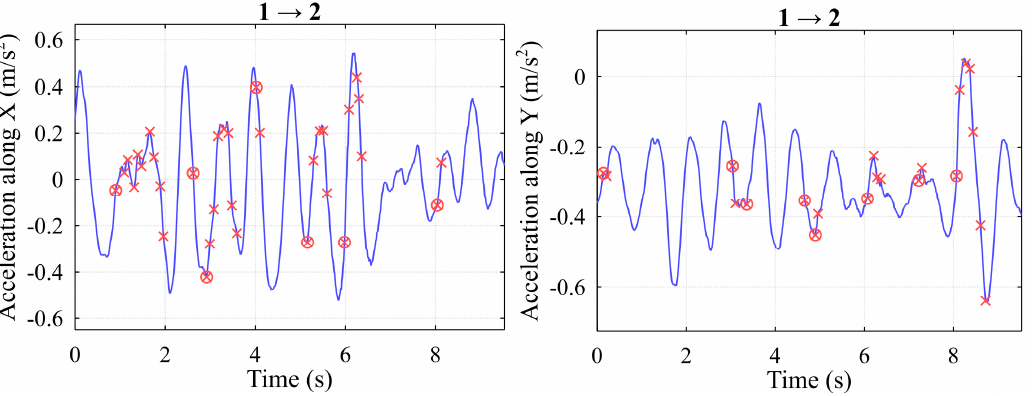
Figure 15. Use case No. 1 with the decreased threshold (detected impacts: ( left ) 7; ( right ) 8). A 10% decrease resulted in three additional detections along the X-axis (refer to Figure 16), and the number of impacts along the Y-axis decreased by two.